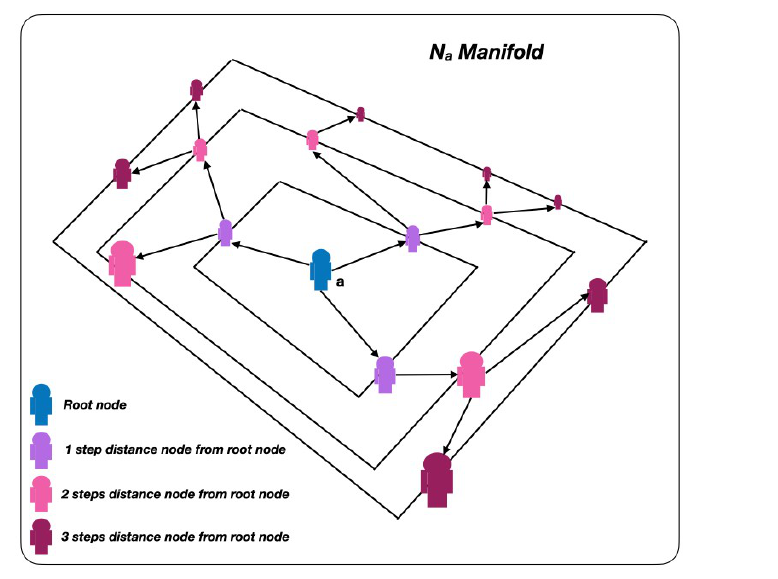
Figure 2. Manifold N a of a given node a of spatial depth k =